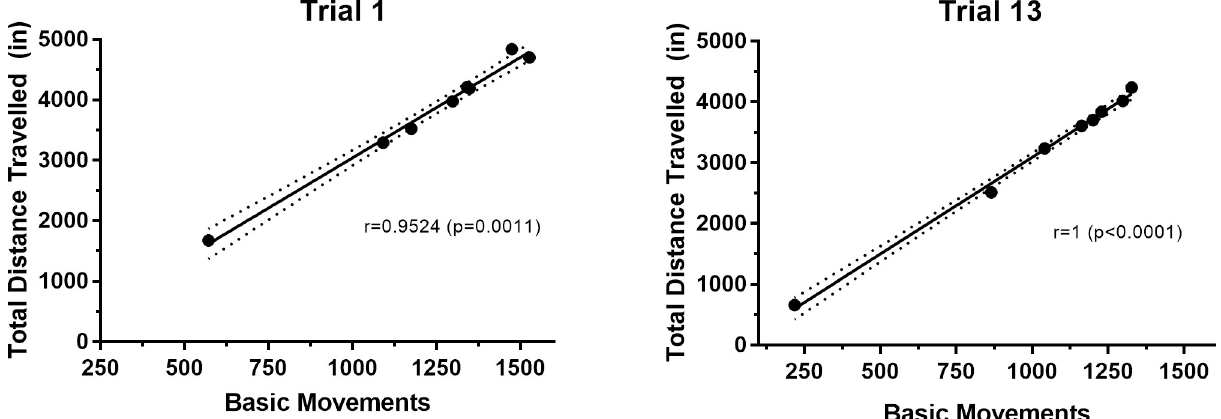
Fig 3. Correlation of basic movements and total distance travelled on the EPM. Basic movements and total distance travelled are highly correlated at the first trial (left-side panel) as well as the final, 13 th trial (right-side panel). Data are presented as the raw value for basic movements and total distance travelled, with the calculated Spearman’s correlation coefficient and p-value shown for the first and last trial.